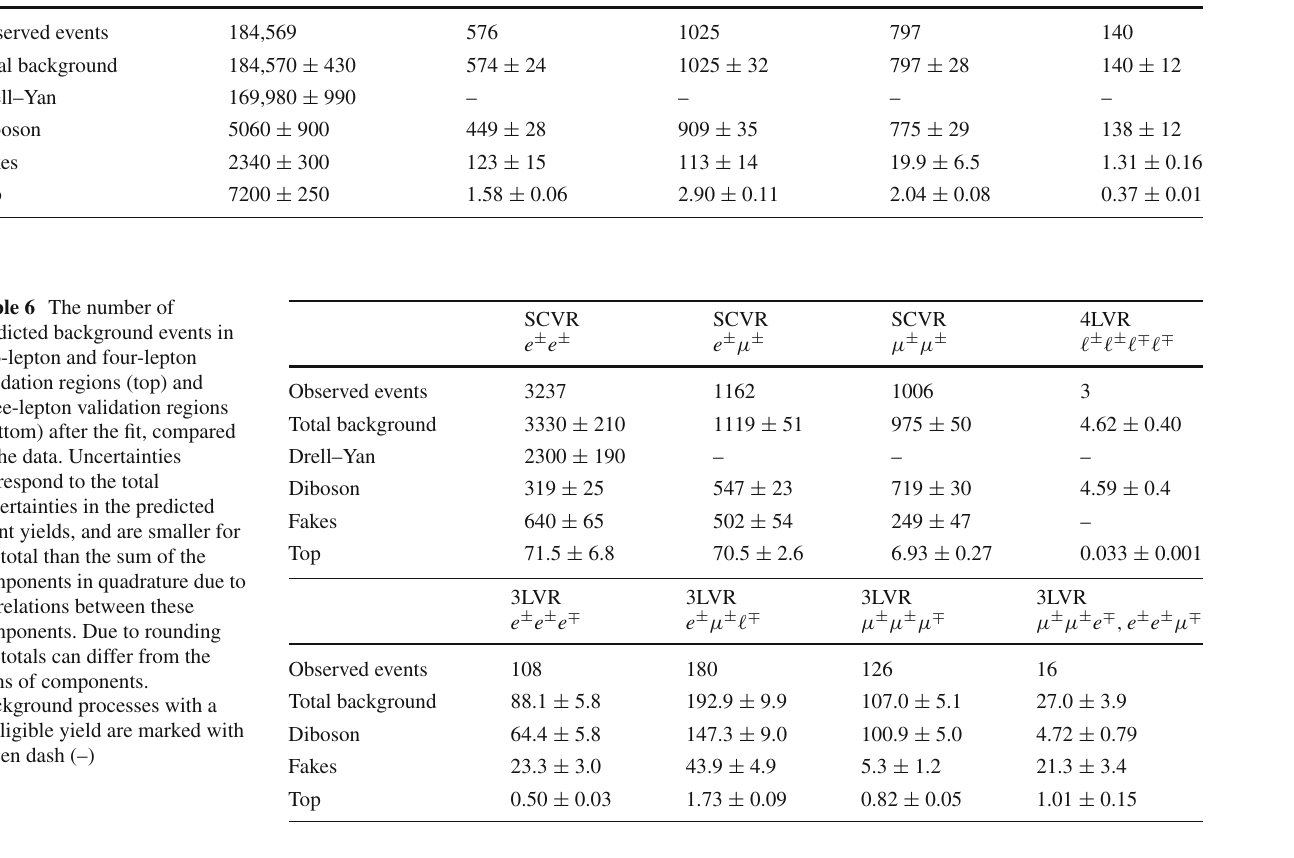
tions between these components. Due to rounding the totals can differ from the sums of components. Background processes with a negligible yield are marked with the en dash (–)